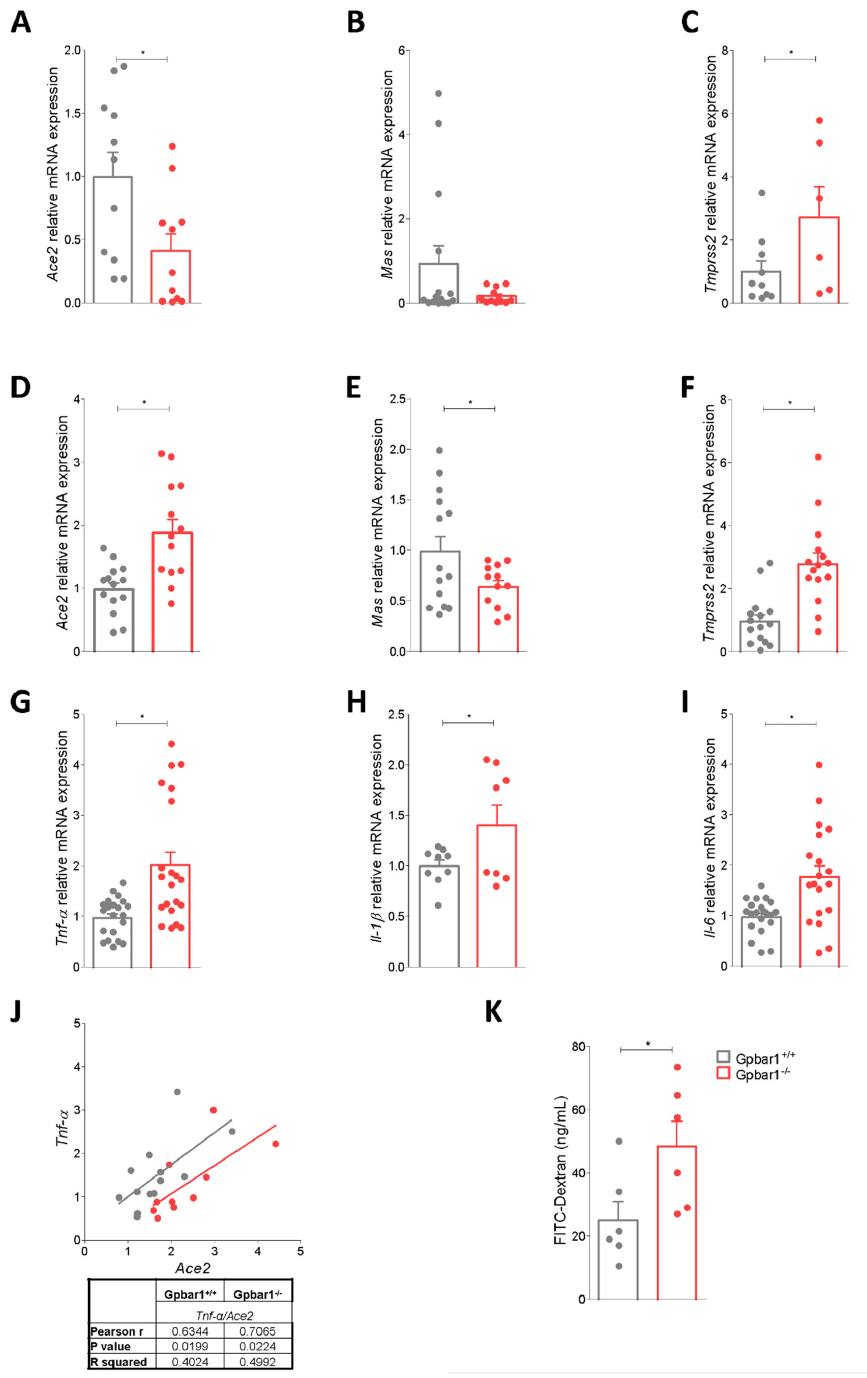
Figure 3. Gpbar1 − / − mice colon show higher levels of Ace2 expression than wild type. The Colon was collected from C57BL/6 male mice (Gpbar1 +/+ ) and their congenic Gpbar1 knock out littermates (Gpbar1 − / − ). Small intestine relative mRNA expression of ( A ) Ace2, ( B ) Mas, ( C ) Tmprss2. Colon relative mRNA expression of ( D ) Ace2, ( E ) Mas, ( F ) Tmprss2 ( G ) Tnf- α , ( H ) Il-1 β and ( I ) Il-6. Data are normalized to Gapdh mRNA. Results are the mean ± SEM, each point represents a mouse; * p < 0.05. ( J ) Correlation graph between Ace2 and Tnf- α expression. ( K ) FITC-dextran